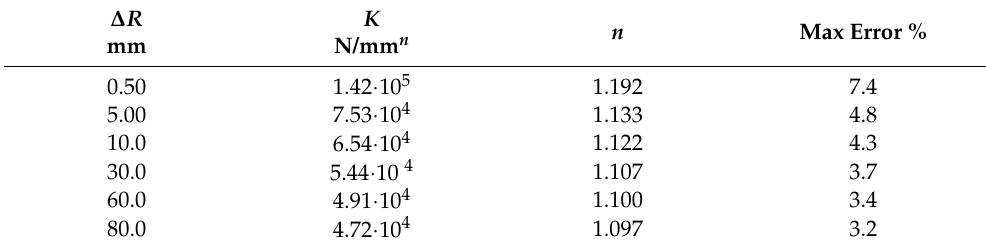
Table 4. Polynomial version of Johnson’s [24] force model (Steel).